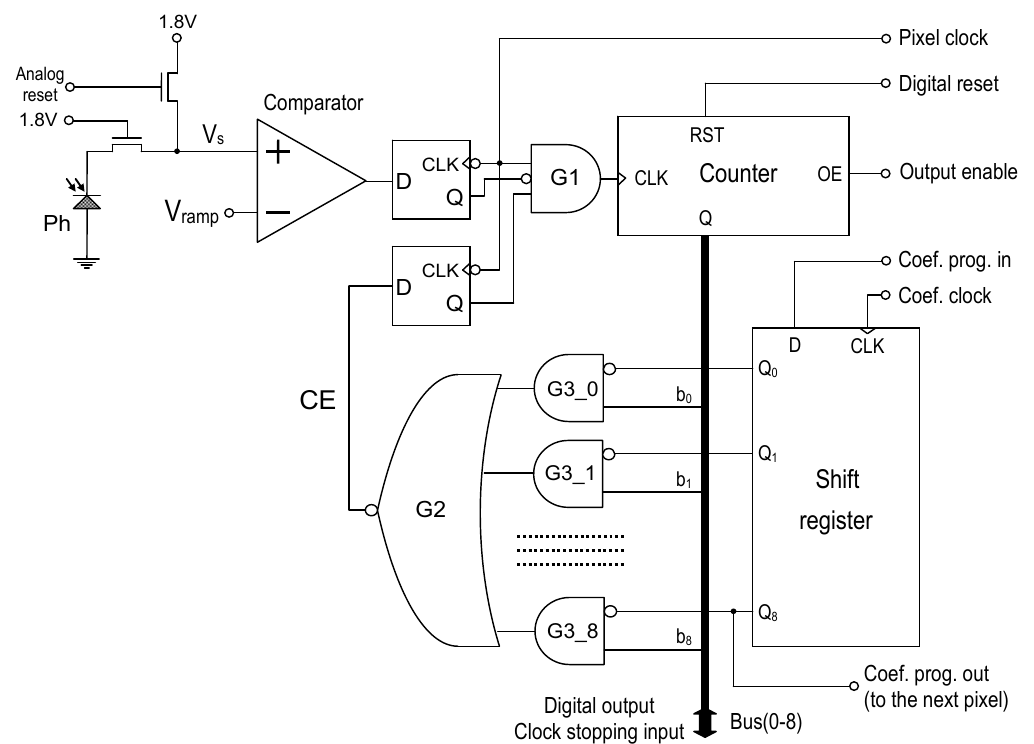
Figure 3. Schematic diagram of the pixel-ADC.